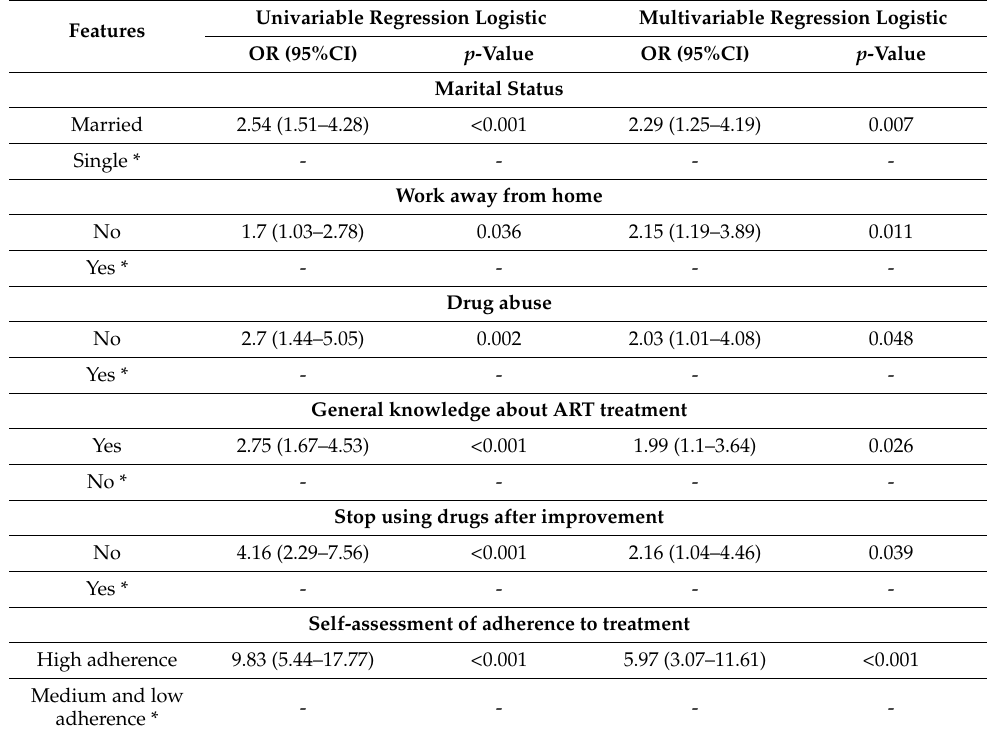
Table 3. Univariable and multivariable regression analyses of the correlation between patients’ characteristics and ART